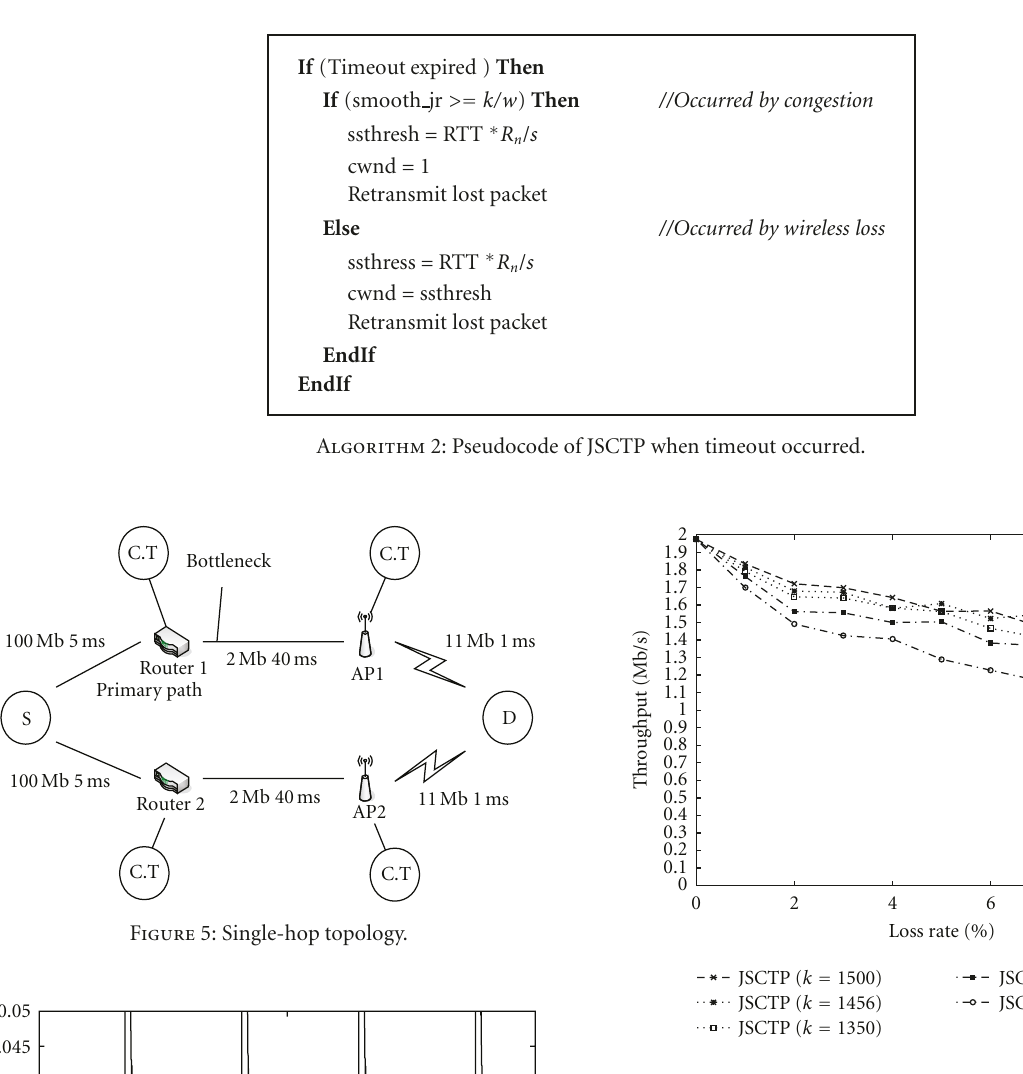
Figure 7: Di ff erent value of k